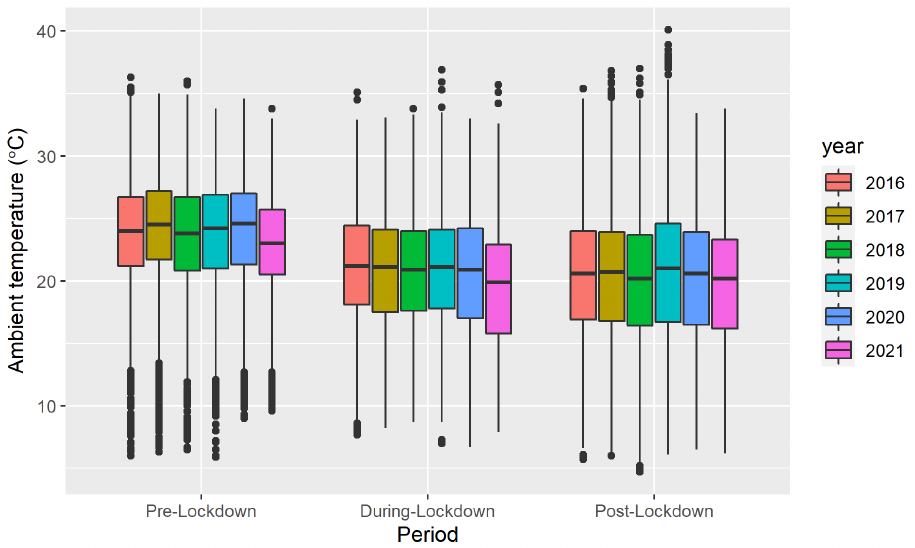
Figure 12. Comparison of ambient temperature for different periods from 2016 to 2021.